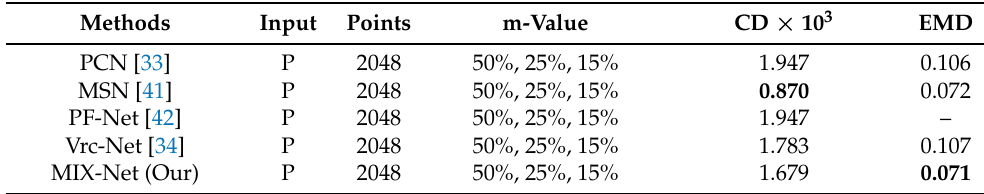
Table 4. Leaf completion results of MIX-Net on seedling point cloud leaf datasets.